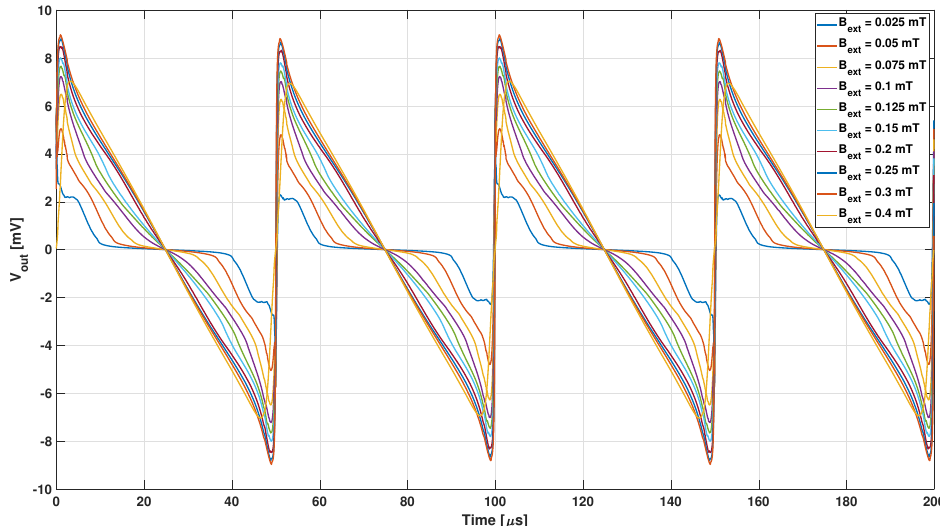
Figure 16. Output voltage obtained with the non-hysteretic B-H curve from JA1 material model for different values of the external magnetic field.